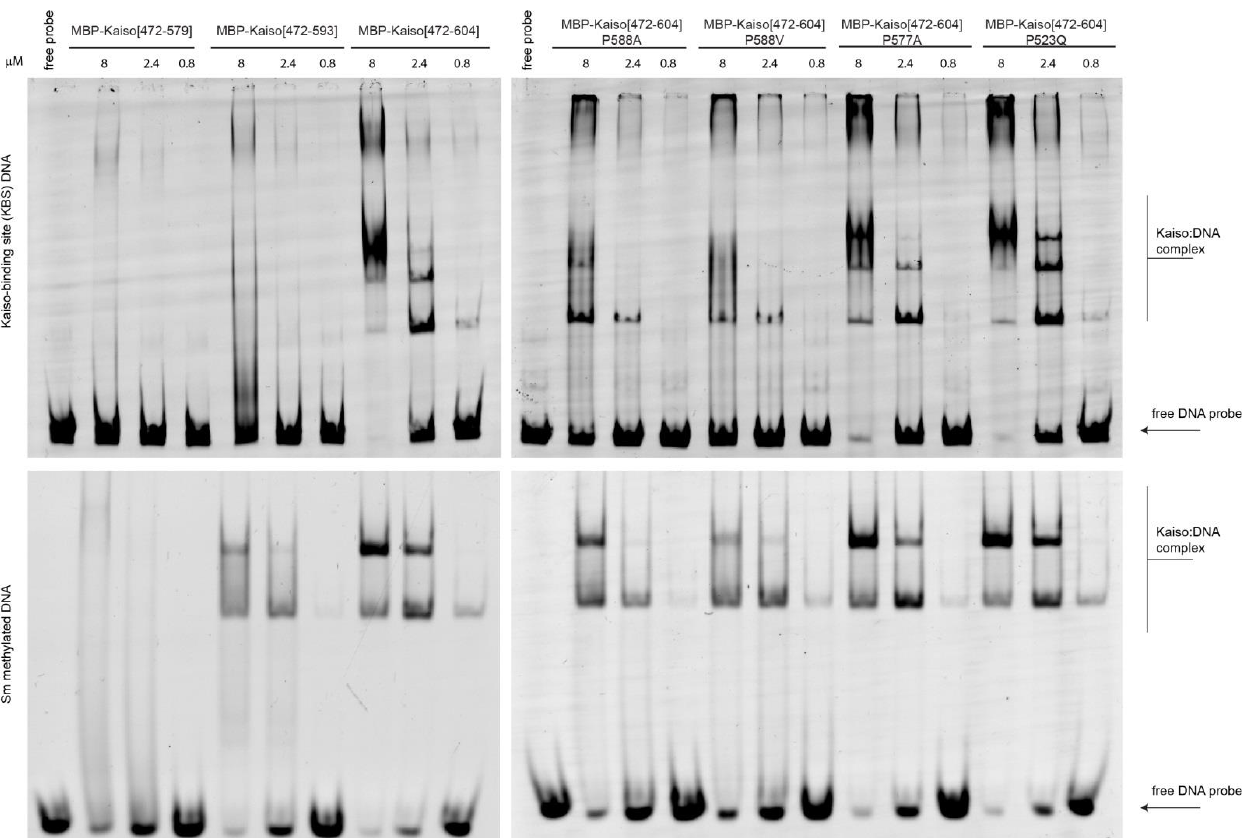
Figure 5. Electrophoretic mobility shift assay to assess the impact of P588 substitutions and deletions of the C-terminal extension on DNA-binding activity of Kaiso protein in vitro. Uncropped gels are shown in Supplementary Figure S6.